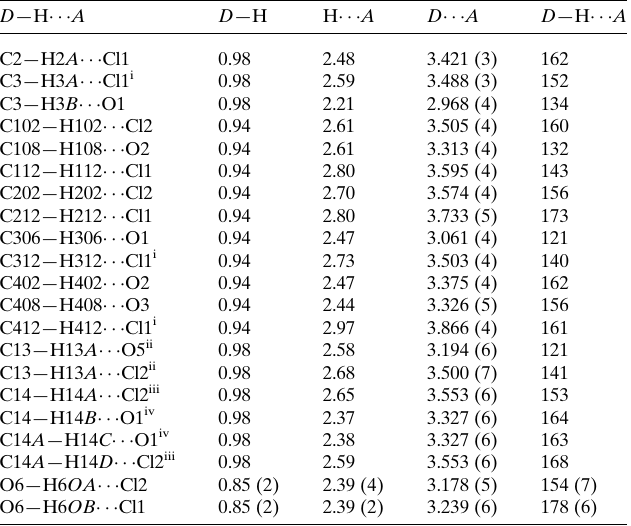
Table 5 Hydrogen-bond geometry (A˚ , (cid:3) ) for 7 .